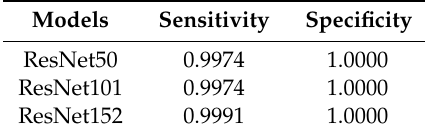
Table 4. Performance Metrics.